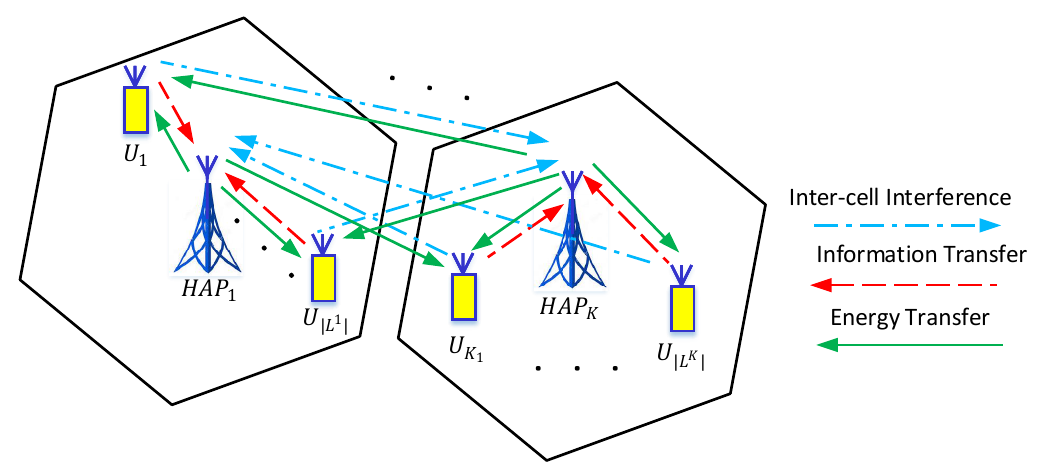
Figure 1. Multi-cell wireless powered communication network